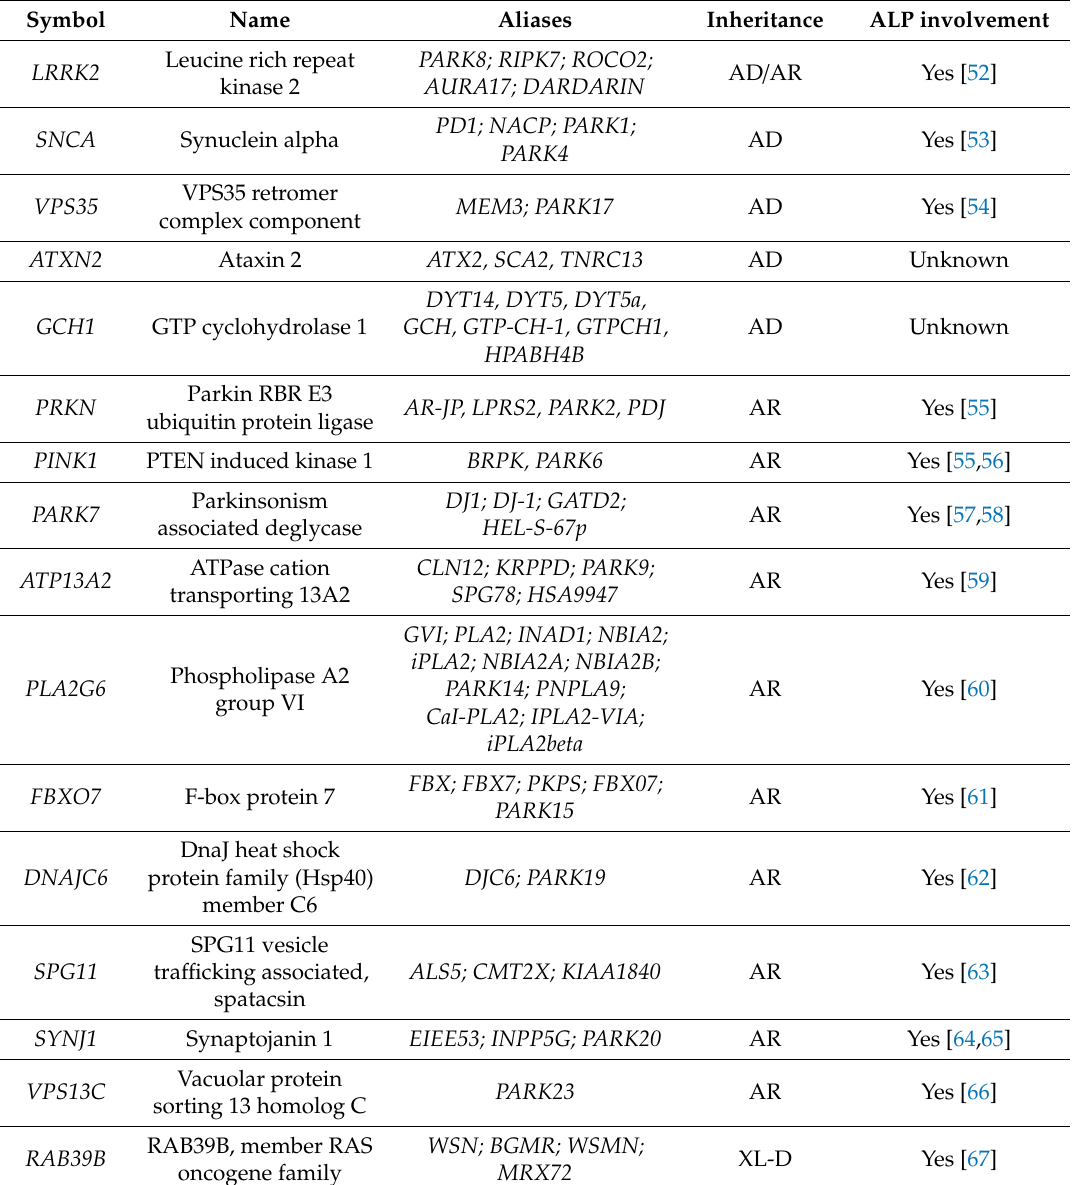
Table 1. Summary of familial PD mutations and their ALP involvement. This table summarizes the genes for which mutations have been associated with familial PD [31] either with an autosomal dominant (AD), autosomal recessive (AR), or X-linked dominant (XL-D) mode of inheritance. The table includes the gene symbol, name and aliases, the mode of inheritance and the current knowledge on their involvement in the autophagy-lysosomal pathway